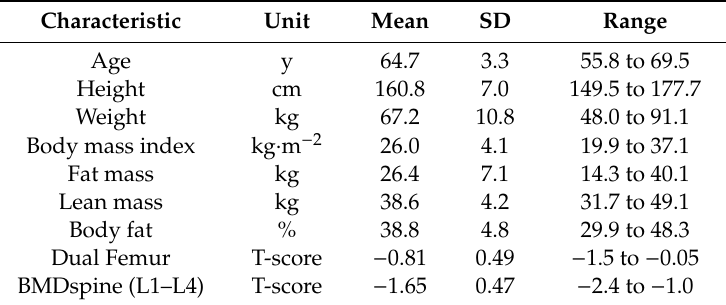
Table 1. Subject population ( n = 16).